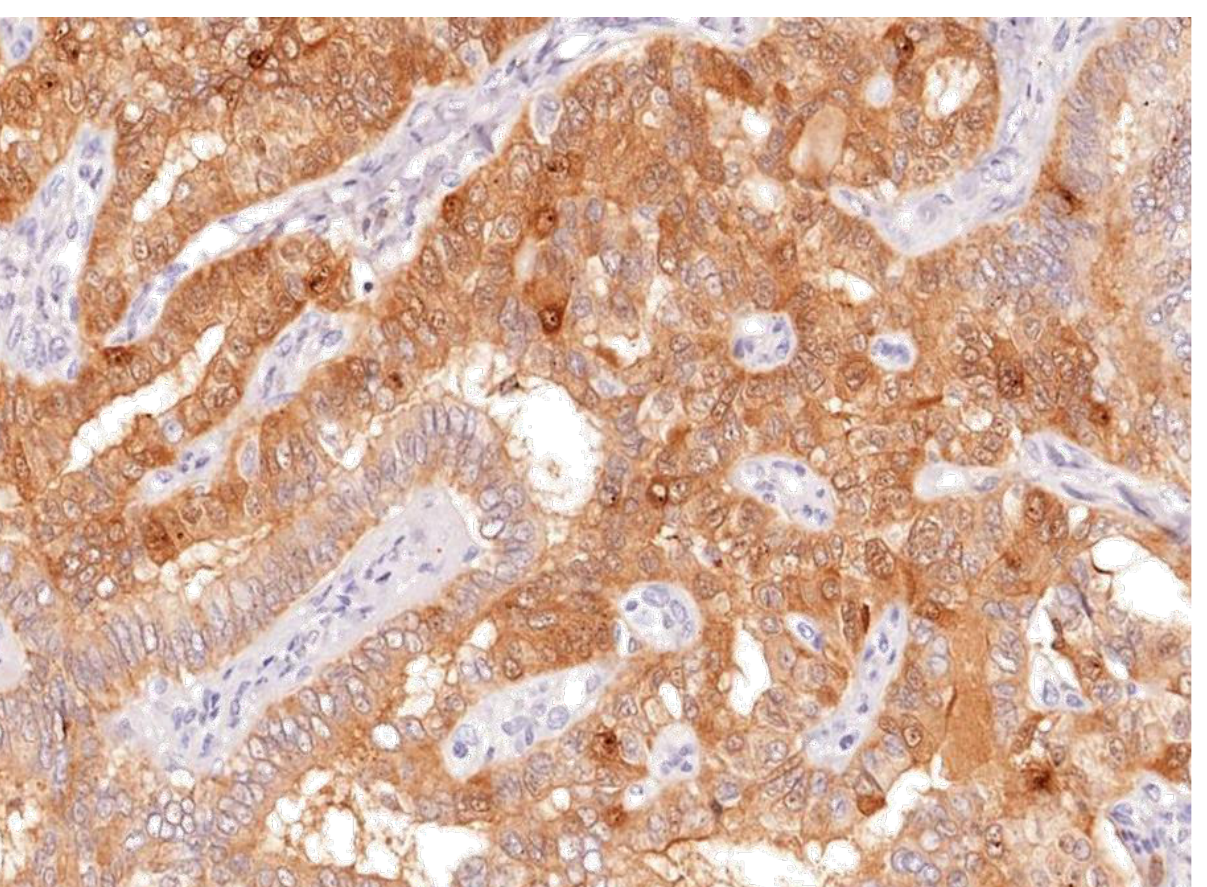
Figure 10. HBME-1 showing cytoplasmic and membranous staining as brown after IHC in papil- lary thyroidcarcinoma (×100).